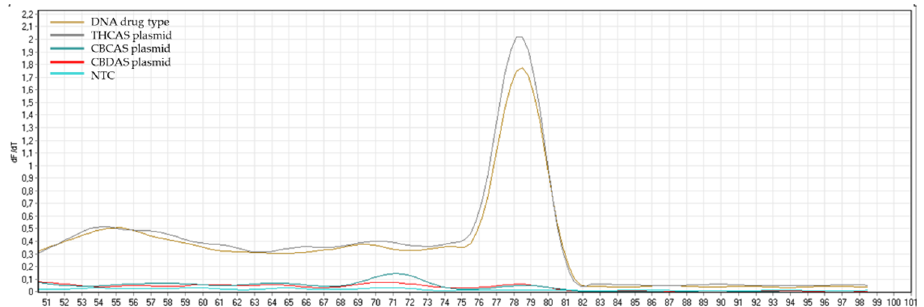
Figure A6. Melting curve plots, which display data collected during a melting curve stage with primers CBDAS_F and CBDAS_R. Peaks in the melting curve may indicate the melting temperature (Tm) of a target or identify nonspecific PCR amplification. No peaks were seen for the no template control (H 2 O) and for negative controls ( THCAS plasmid and CBCAS plasmid).